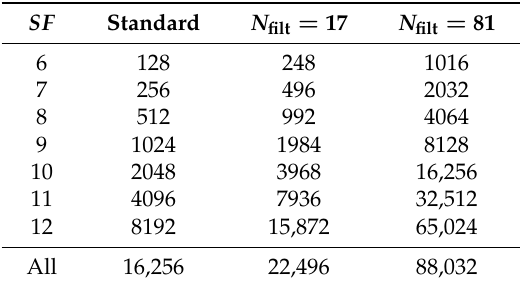
Table 3. Total number of samples ( N TX ) for a standard LoRa system and a system with chirp segmentation: Length-17 and 81